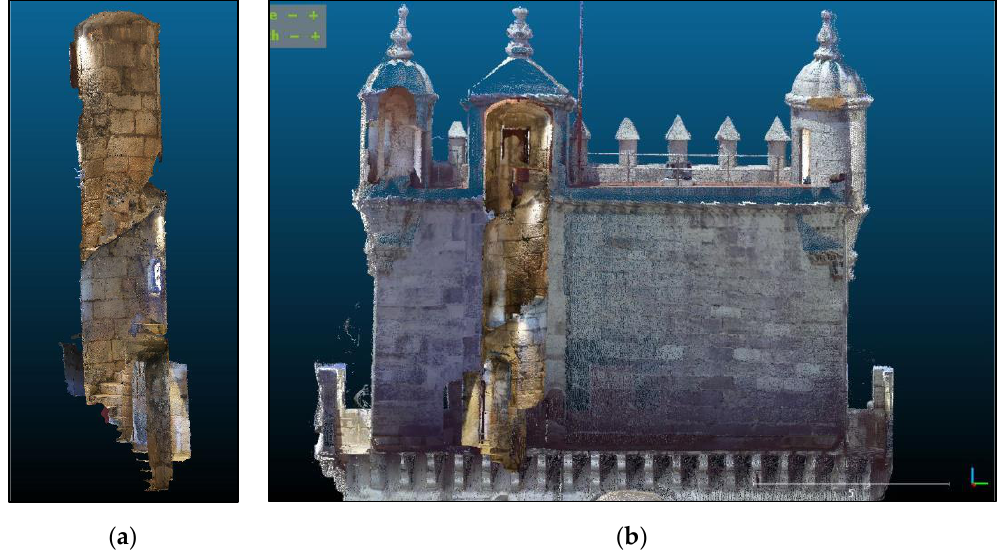
Figure 9. ( a )Part of the point cloud of the spiral staircase between N05 and N06; ( b ) Point cloud of the spiral staircase aligned with main cloud.